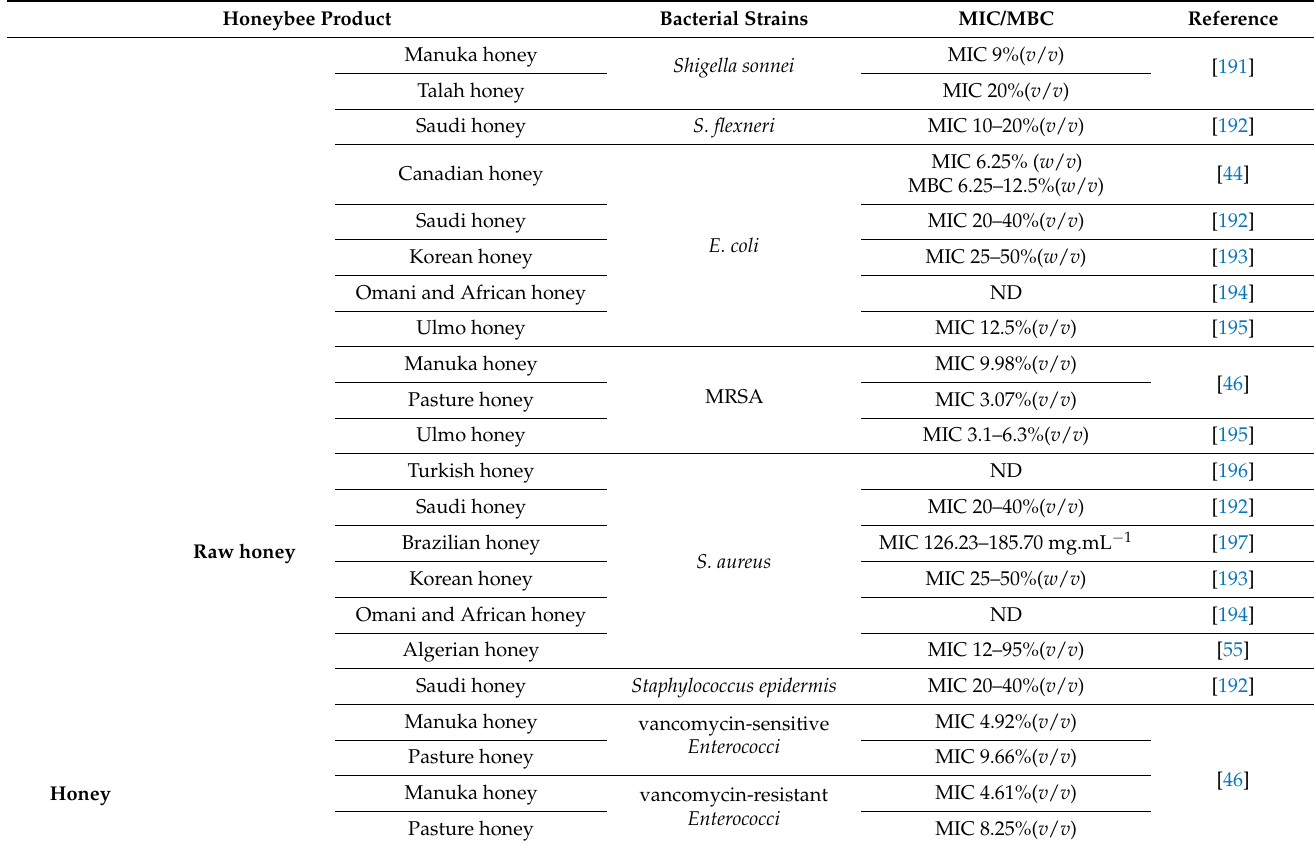
Table 1. Summary of all the bacterial strains susceptible to each honeybee product. The minimum inhibitory effect (MIC) as well as the minimum bactericidal concentration (MBC) of each of the beehive products are also shown (ND: none